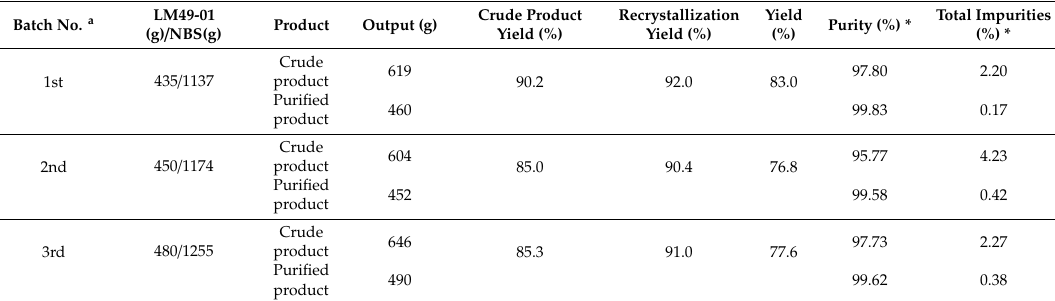
Table 9. Process validation of intermediate LM49-02 .